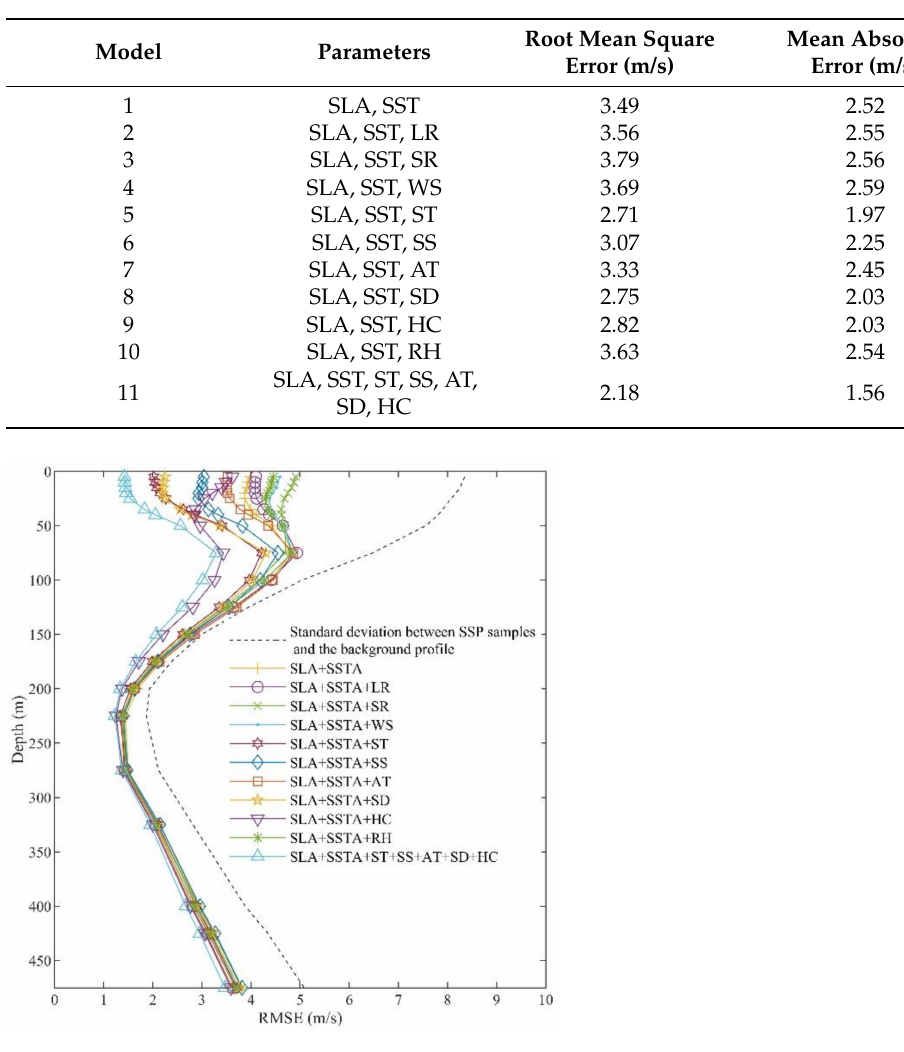
Figure 3. Results of SSP estimation for each